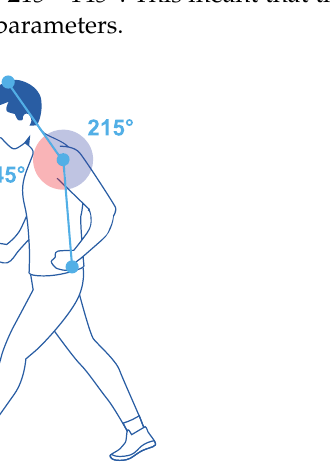
Figure 1. Analysis of the positions by the RULA method: ( left ) conventional socket, ( right ) ergonomic socket.